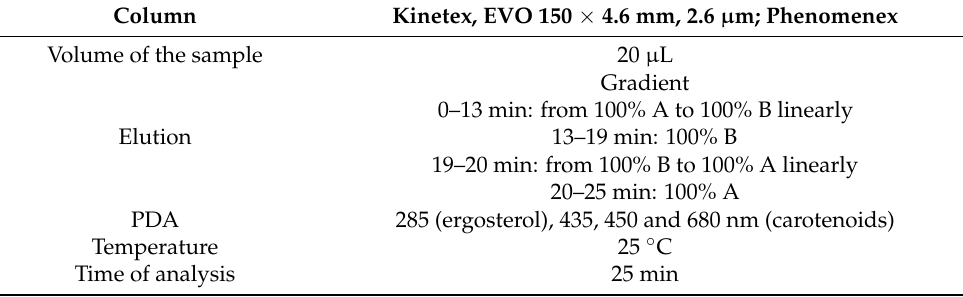
Table 4. Conditions of HPLC separation of carotenoids, sterols and ubiquinone.